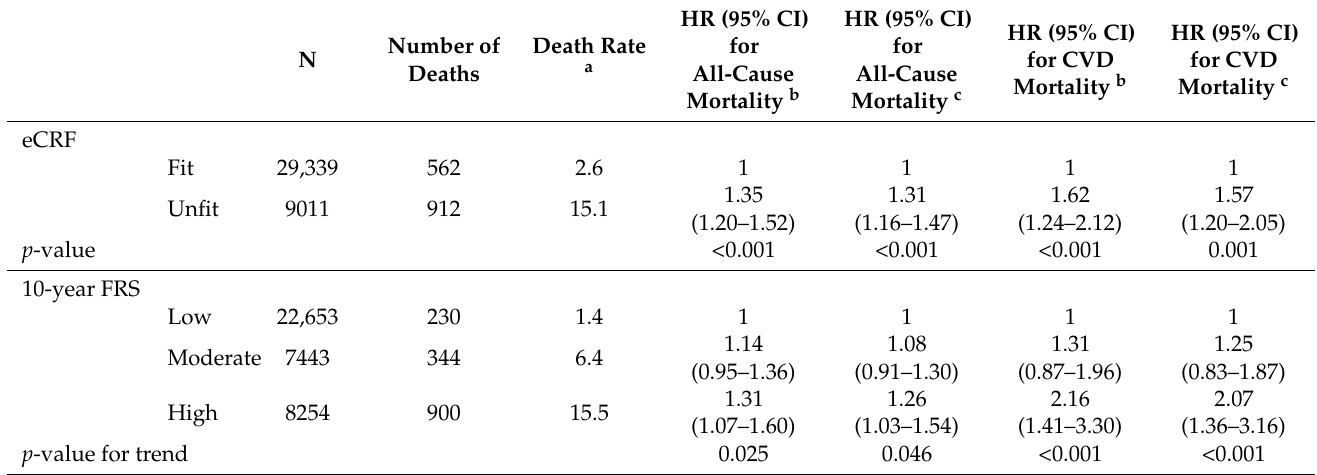
Table 3. All-cause and CVD mortality risks stratified by 10-year Framingham risk score (FRS) and estimated cardiorespiratory fitness (eCRF).